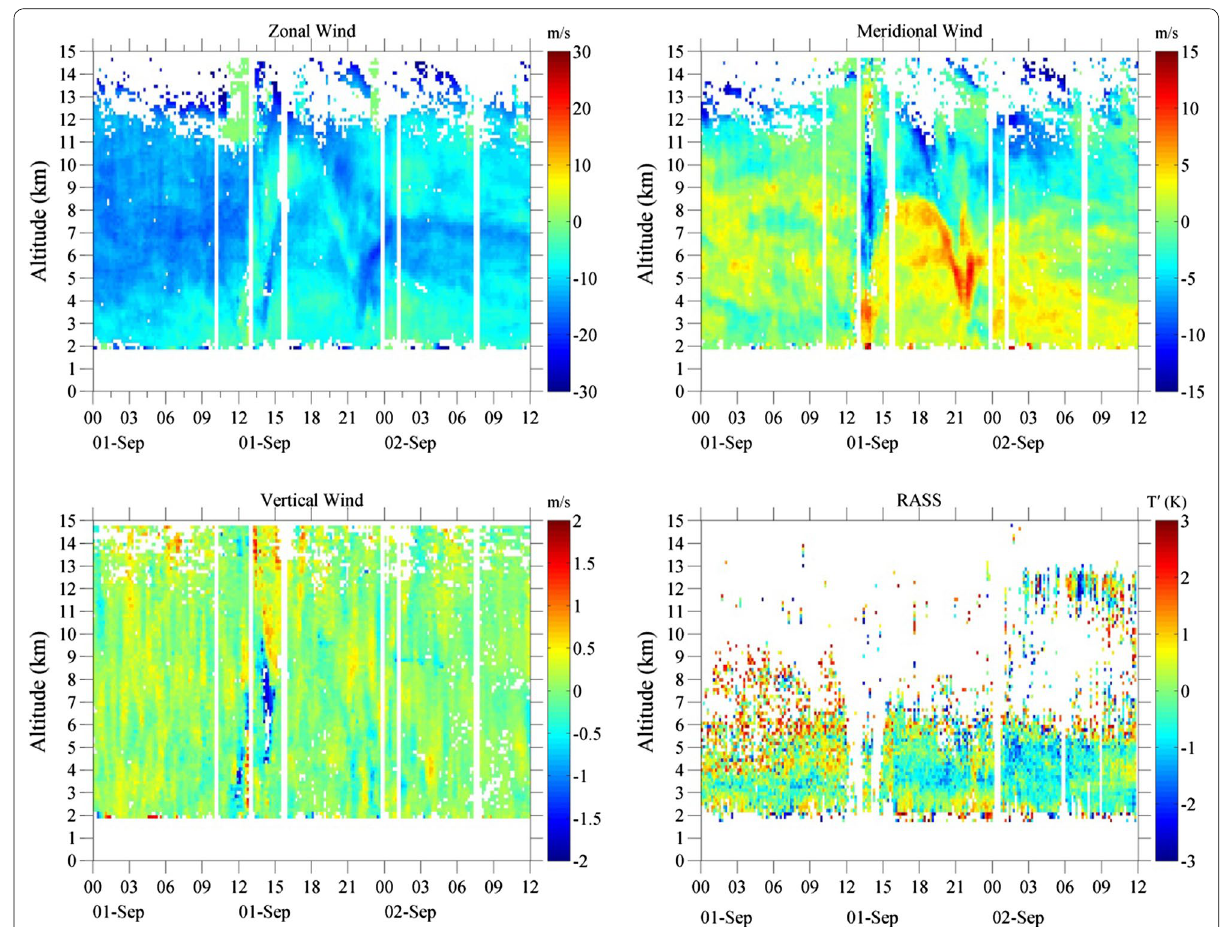
Fig. 20 Enlarged plots of u (top-left), v (top-right), w (bottom-left), and T’ (bottom-right) from 00:00 LT on September 1 to 12:00 LT on September 2, 2016. Averaging time is 10 min